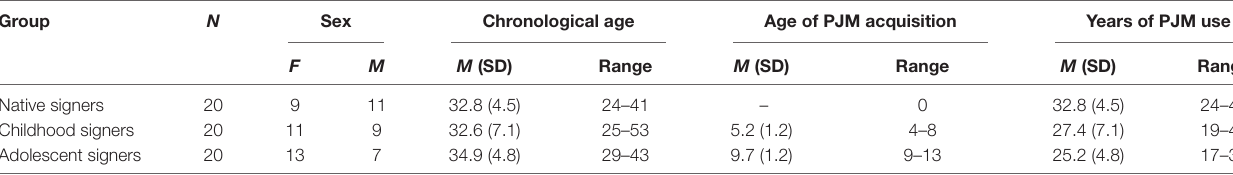
TABLE 1 | Characteristics of the PJM participant groups. Group N Sex Chronological age Age of PJM acquisition Years of PJM use F Native